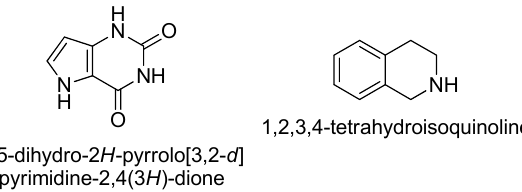
Figure 5. Linkers designed to replace the 7-hydroxy-2 H -chromen-2-one moiety used in 7 and 8 .